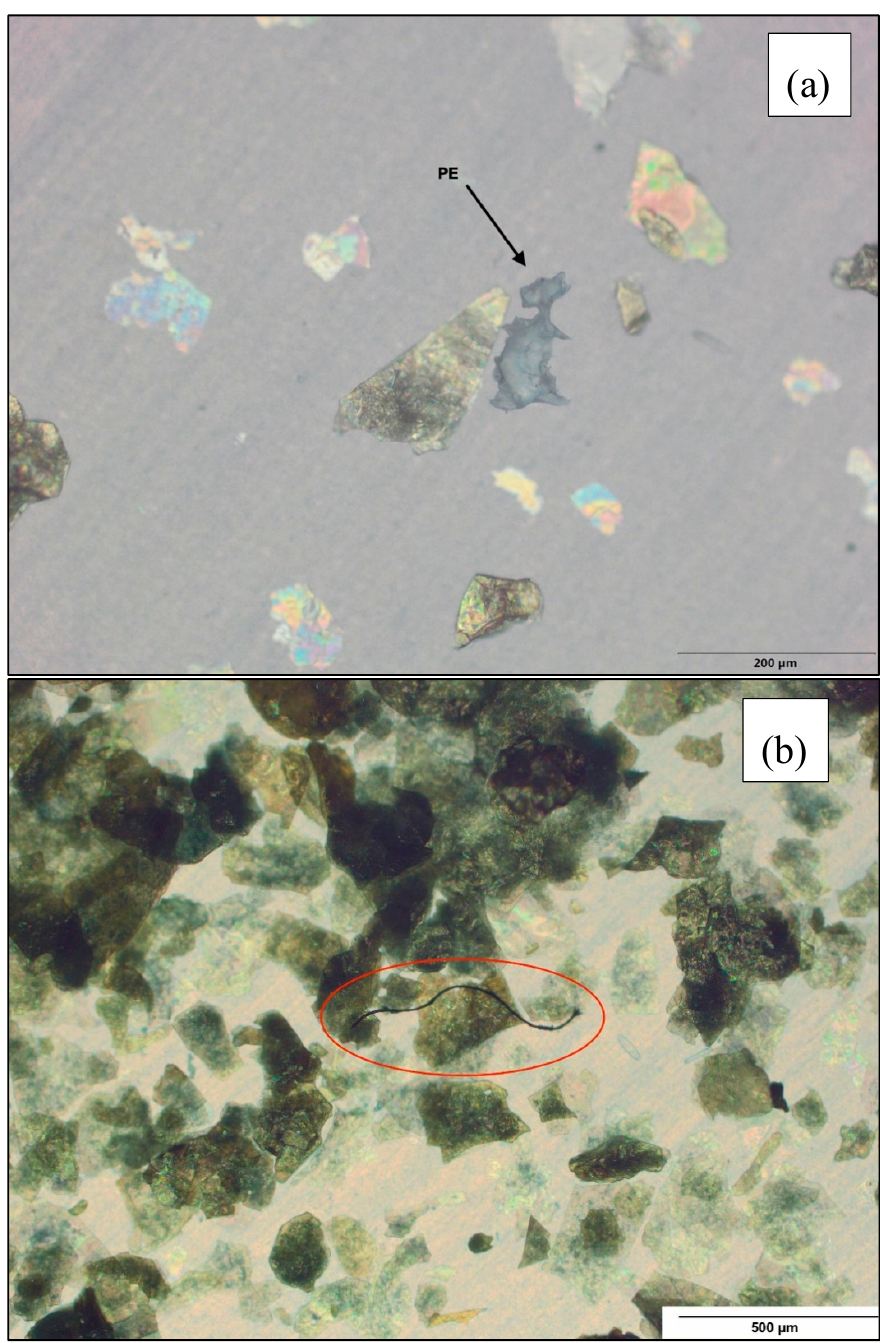
Figure 7. ( a ) Plastic microparticle identified in the sample of the main hole at 8 m depth in the 250–125 μ m fraction and ( b ) blue fibre found in the sample of the main hole at 33 m depth in the 250–125 μ m fraction.